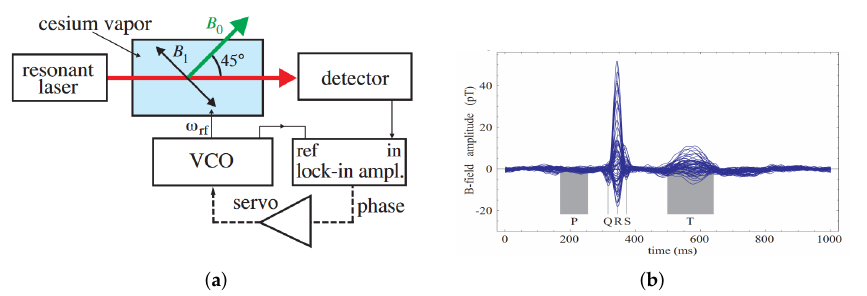
Figure 14. ( a ) Schematic set up of the optically-pumped Mx-magnetometer in the phase-locked mode; ( b ) MCGs taken on the grid above the chest, where P indicates atrial depolarization, QRS is responsible for ventricular depolarization, and T represents ventricular repolarization